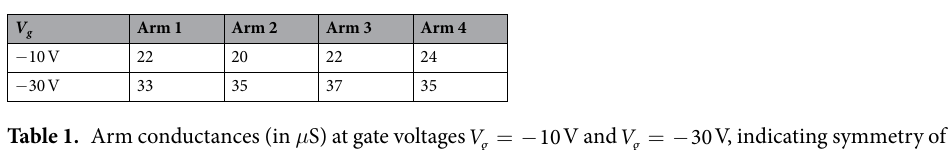
measured at = V 30 mV using the bias configuration C: Ingoing currents b g g